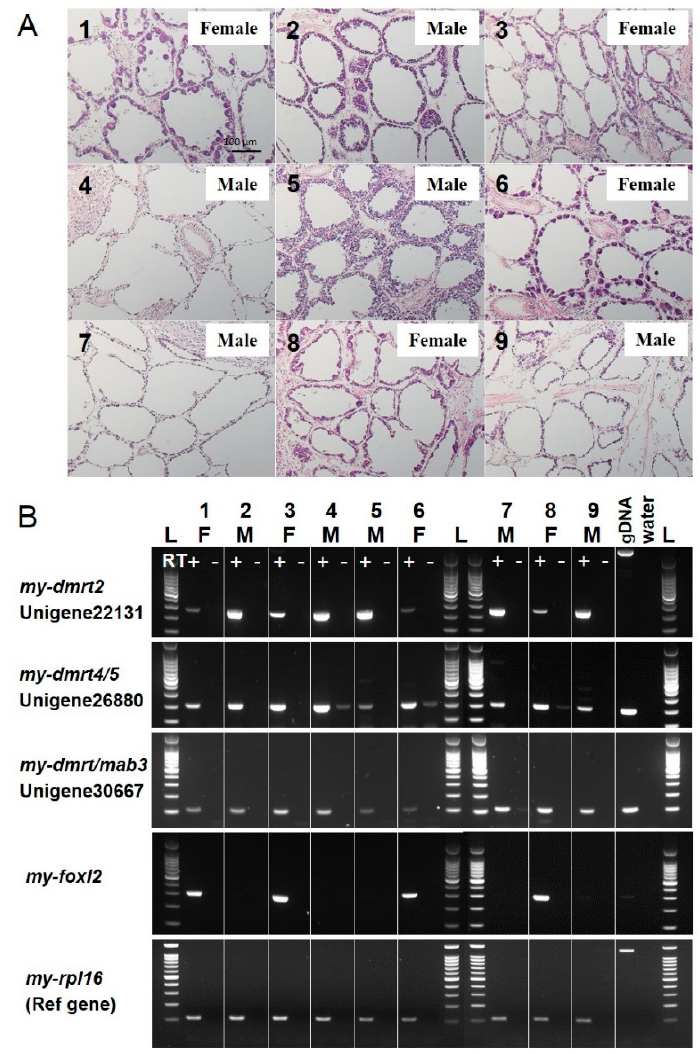
Figure 5. Distribution of my-dmrt2 and my-foxl2 mRNAs between ovaries and testes in the Yesso scallop at the early differentiating stage. Nine specimens were subjected to histological analysis ( A ) and semi-quantitative RT-PCR ( B ). ( A ) HE staining was performed for the above assessed gonad specimens. The numbers are as for the specimens analyzed in RT-PCR. At this stage, males and females possess proliferating spermatogonia and immature oocytes along the wall of germinal acini. Females are distinguished from males by the presence of oocytes. ( B ) Gonad cDNAs and RT controls (without reverse transcriptase) for females ( n = 4) and males ( n = 5) were analyzed. Genomic DNA and water samples were used as negative controls; my-rpl16 was used as an endogenous reference gene. Amplicon sizes in base pairs are indicated in Table 2.